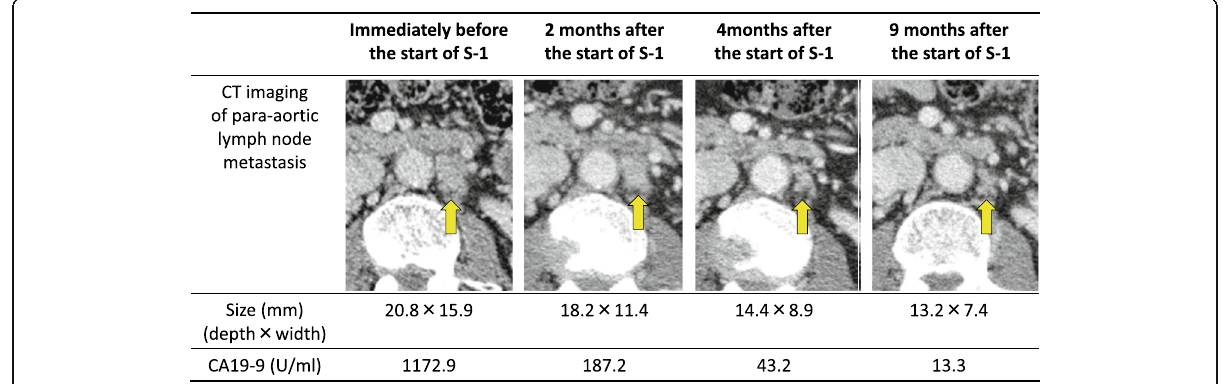
Fig. 3 Changes in the appearance and size of para-aortic lymph node metastasis on axial CT imaging and CA19-9 after the start of